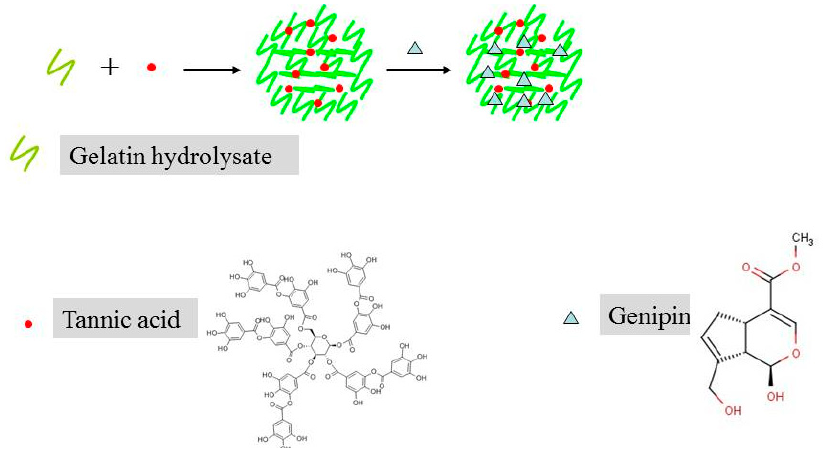
Figure 1. Schematic diagram of the preparation of genipin-treated tannic acid-induced gelatin hydrolysate (GP-GED-TA) gel particles.